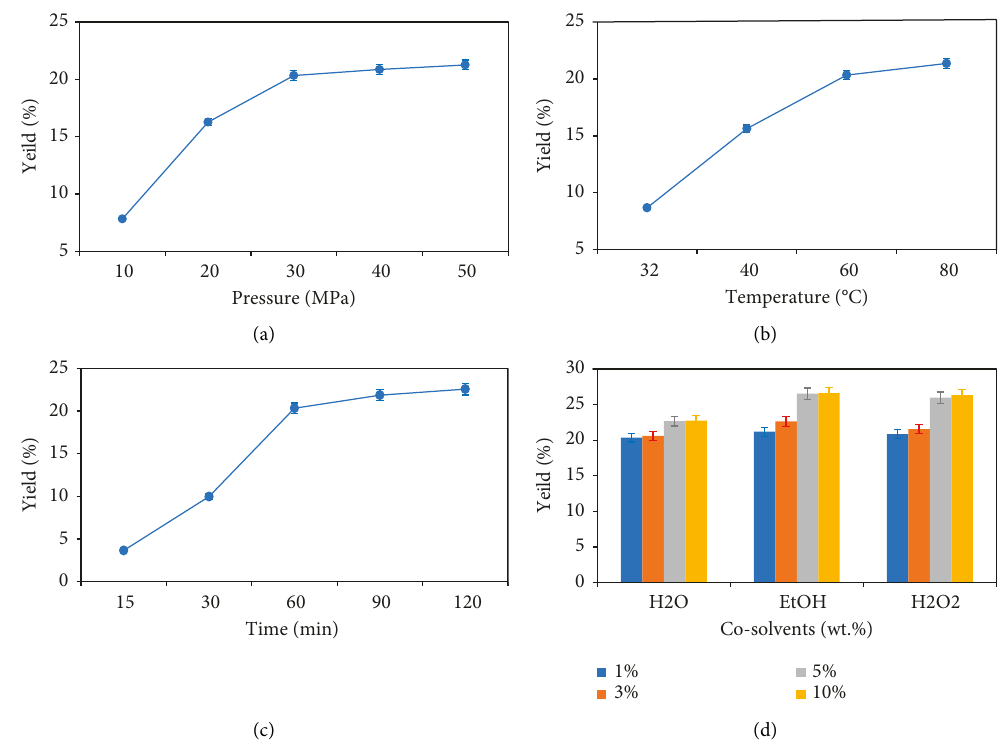
Figure 1: Lipids’ extraction from municipal sewage sludge using scCO 2 . (a) Effects of pressure, experimental conditions: temperature of 60 ° C and treatment time of 60min. (b) Effects of temperature, experimental conditions: pressure of 30MPa and treatment time of 60min. (c) Effects of treatment times, experimental conditions: pressure of 30 MPa and temperature of 60 ° C. (d) Effect of cosolvents, experimental conditions: pressure of 30MPa, temperature of 60 ° C, and treatment time of